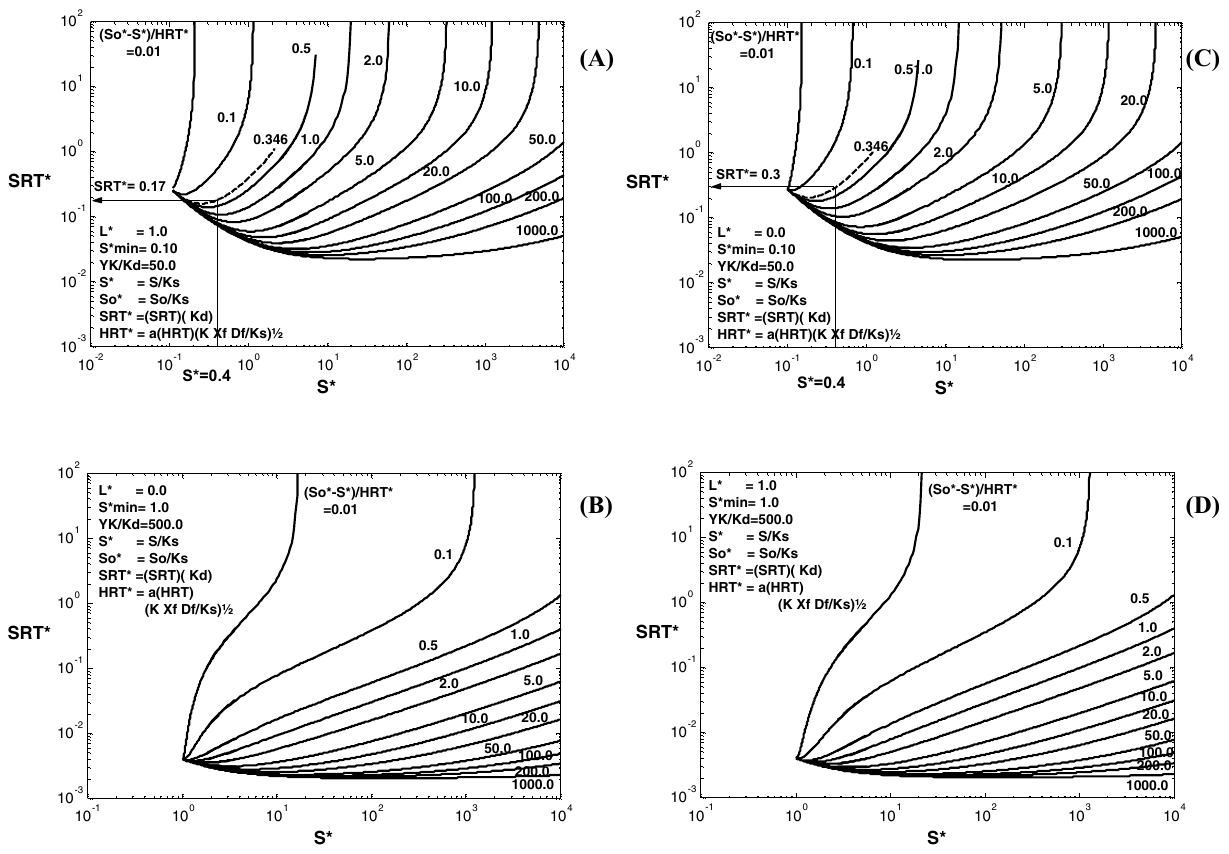
L * = 0.0, S ∗ min = 0.10, b L * = 0.0, S ∗ min = 1.0, c L * = 1.0, S ∗ min = 0.10 and d d = 50.0, a